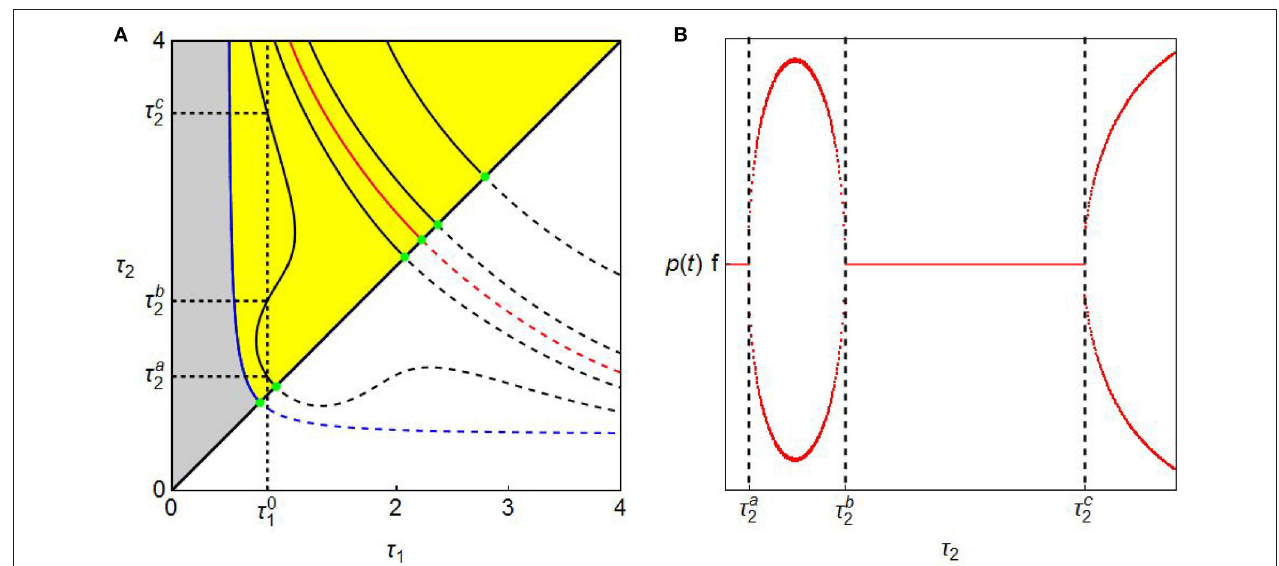
FIGURE 5 | Delay destabilizing and stabilizing effects: (A) Stability switching curves; (B) Bifurcation diagram.